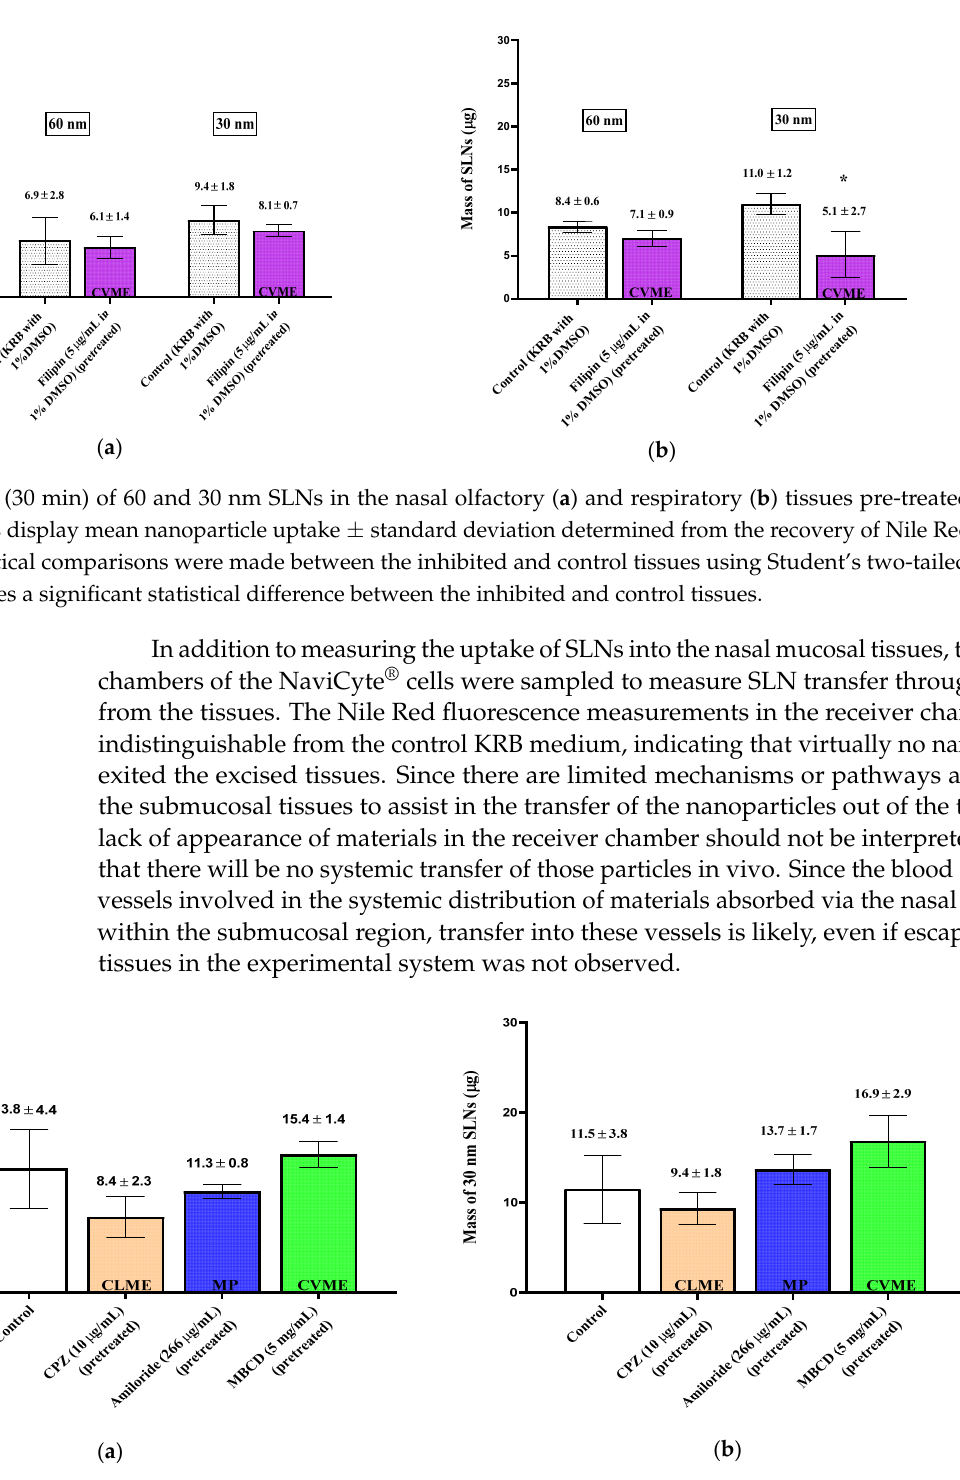
Figure 3. Uptake (30 min) of 60 nm SLNs in the nasal olfactory ( a ) and respiratory ( b ) tissues in the presence of endocytic inhibitors. Bar graphs display mean nanoparticle uptake ± standard deviation determined from the recovery of Nile Red from the tissues. Statistical comparisons were made between each of the inhibited tissues and the control tissues using Student’s two tailed t -test ( p < 0.05). * denotes a significant statistical difference between the inhibited and control tissues.